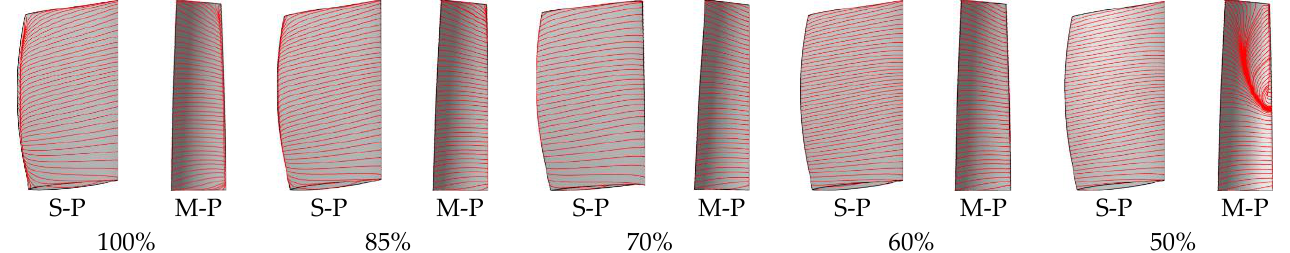
Figure 8. Limiting streamlines on S-P and M-P surfaces at different loads (2.7 MPa back pressure, last stage blade).